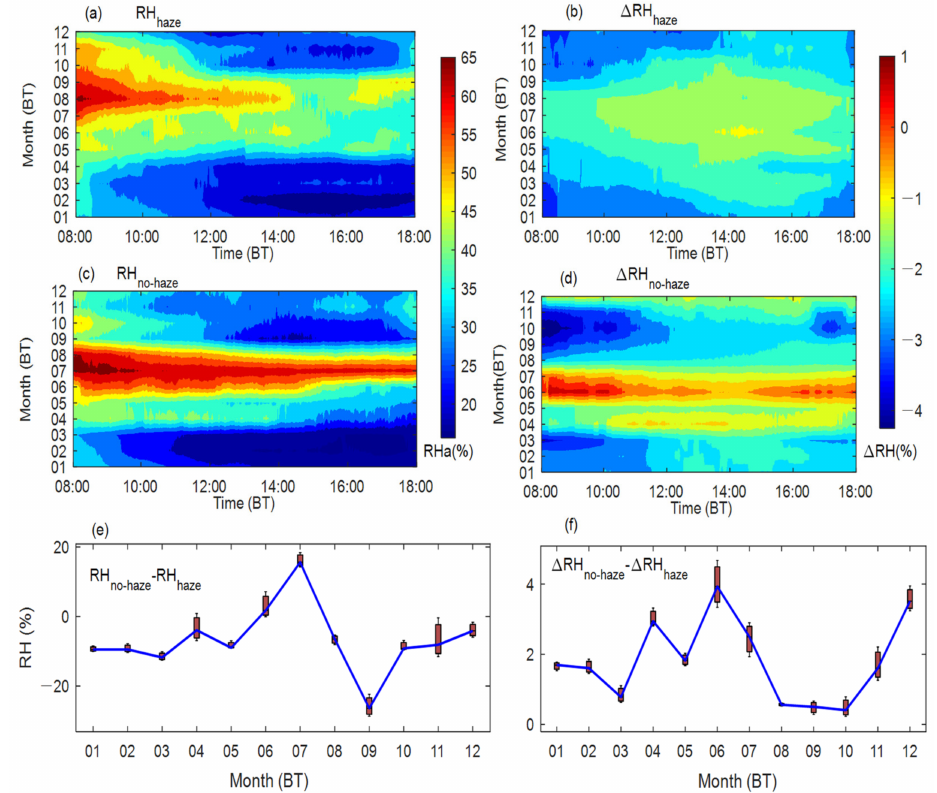
Figure 7. Temporal distribution of average relative humidity within the BL during ( a ) the haze events RH haze and ( c ) the no-haze events RH no − haze ; the distribution of monthly average vertical relative humidity difference within the BL during ( b ) the haze events ∆ RH haze and ( d ) the no-haze events ∆ RH no − haze in different months; ( e ) the difference in the RH no − haze and RH haze ; ( f ) the difference in the ∆ RH no − haze and ∆ RH haze